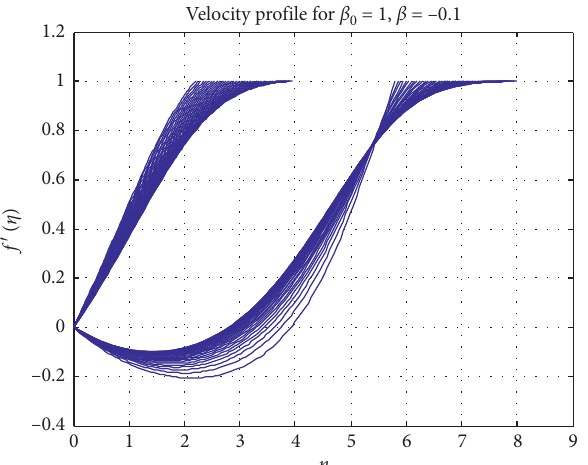
Figure 7: Velocity profile for β � − 0 .